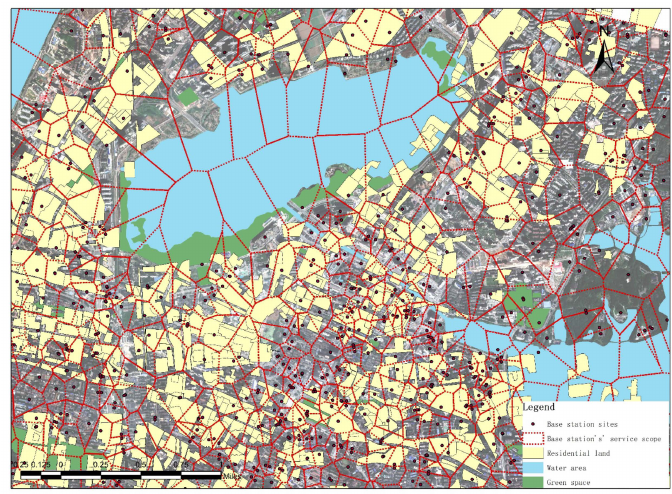
Figure 5. Schematic illustration of the relationship between base stations and residential land.